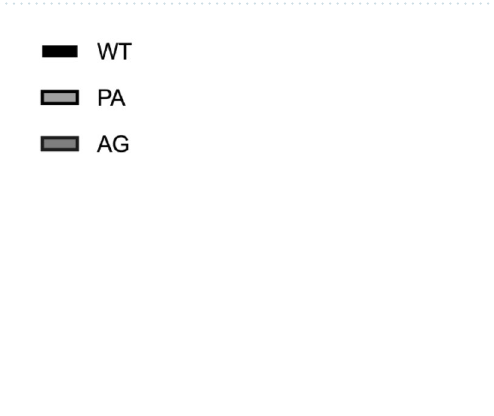
Figure 3. The genomic insertion site in the transgenic strain. ( A ) The genomic insertion site in the AG strain, BmChr.4; ( B ) The genomic insertion site in the PA strain, BmChr.26. Both the AG and PA strains exhibited a single insertion.